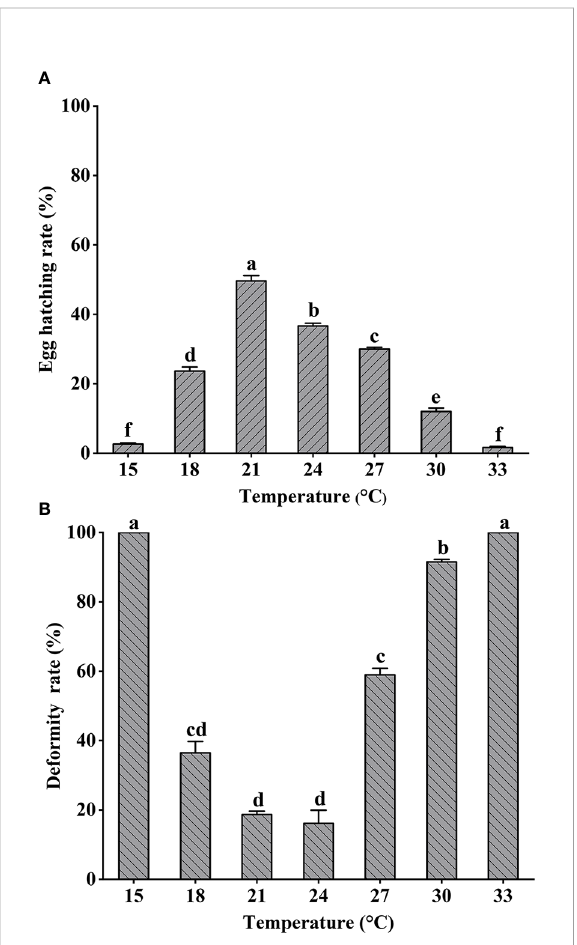
FIGURE 2 Larimichthys crocea fertilized eggs hatching rate (A) and hatched larvae deformity rate (B) exposed to different temperatures (mean ± SD). Labeled means without a common letter differ ( P <